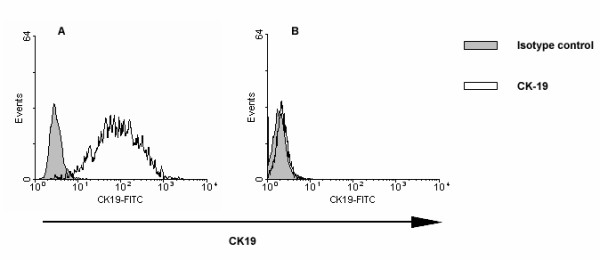
CK19 expressions in A431 cells (A) and human white blood cells (B). The cells were fixed, permeabilized with 0.01% Triton X-100, stained with FITC-conjugated mouse anti-human CK19 antibody or FITC-conjugated mouse IgG1 and analyzed by flow cytometry.